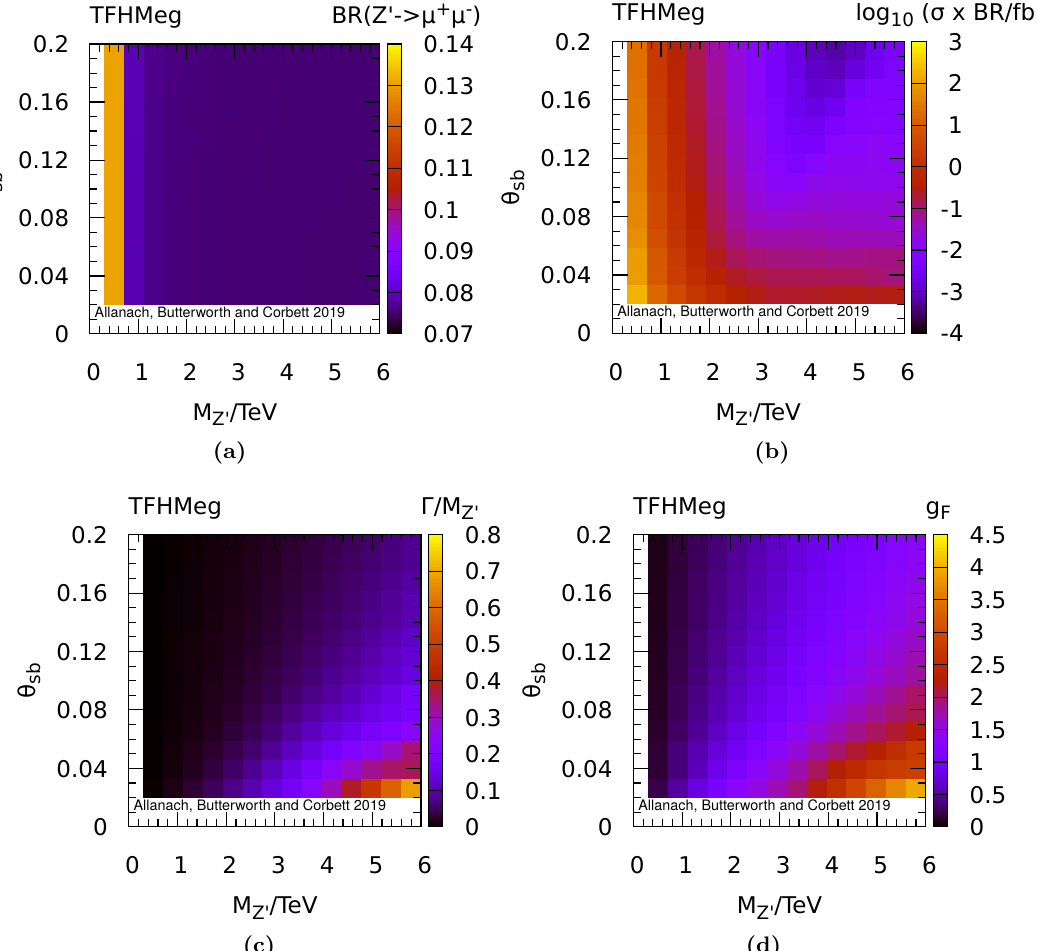
Figure 8 . Properties of the TFHMeg. Everywhere throughout the parameter plane shown, the NCBAs are (cid:12)t by (cid:12)xing g F as in eq. (2.16) for x = 1 : 06 and shown in panel